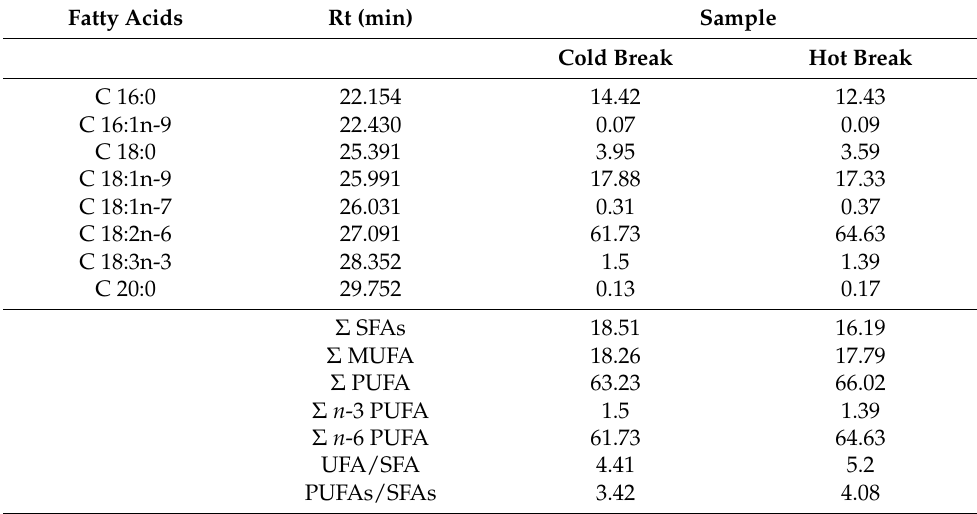
Table 4. Fatty acid composition (%) of tomato seed oil derived from cold break and hot break production lines; analytical measurements were conducted with three replicates ( n =